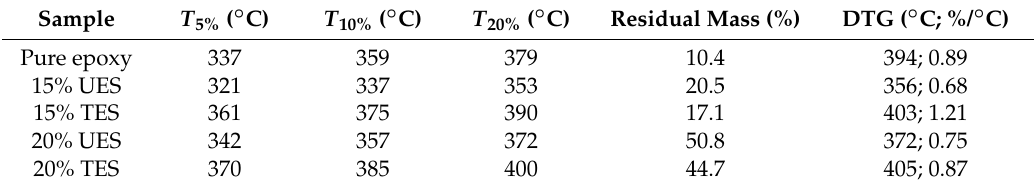
Table 7. TGA and DTG data of pure, UES and TES composites investigated under nitrogen